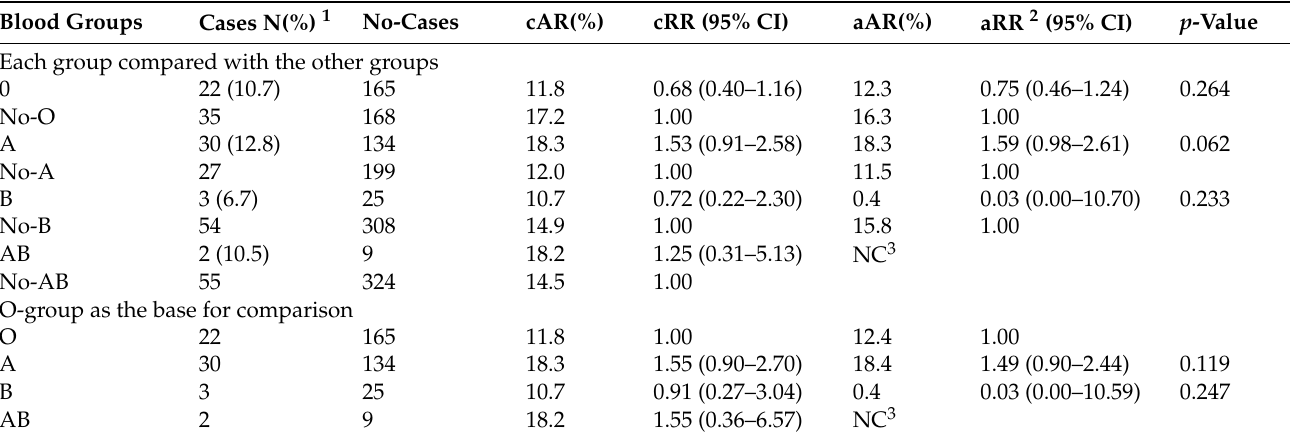
Table 3. Asymptomatic SARS-CoV-2 infections by ABO blood groups. Crude attack rate (cAR) and adjusted (aAR). Crude relative risk (cRR) and adjusted (aRR); 95% confidence interval (CI).